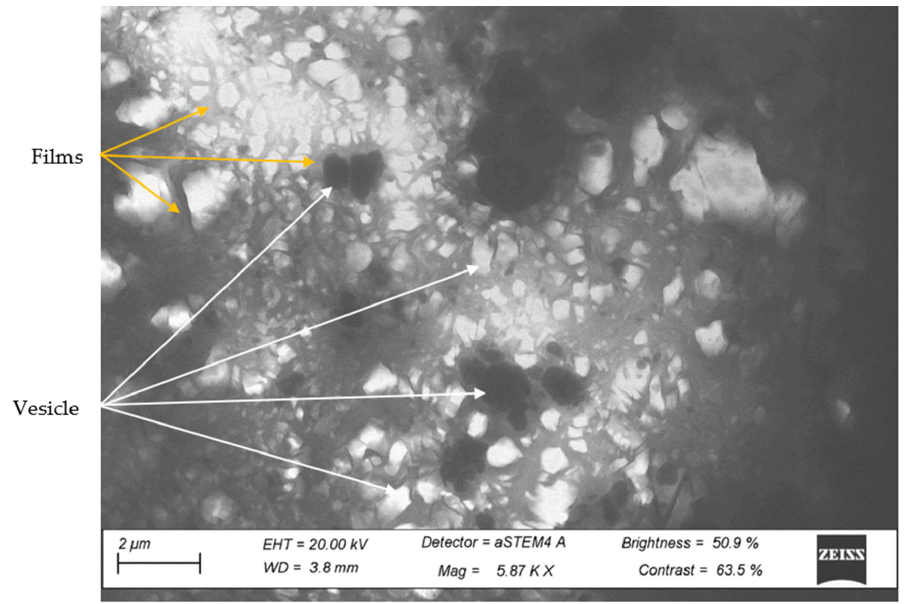
Figure 10. STEM image of third phase. Vesicles: bright/dark amorphous areas with distinct boundaries indicated by white arrows; films: filamentous grey regions surrounding vesicles indicated by yellow arrows.